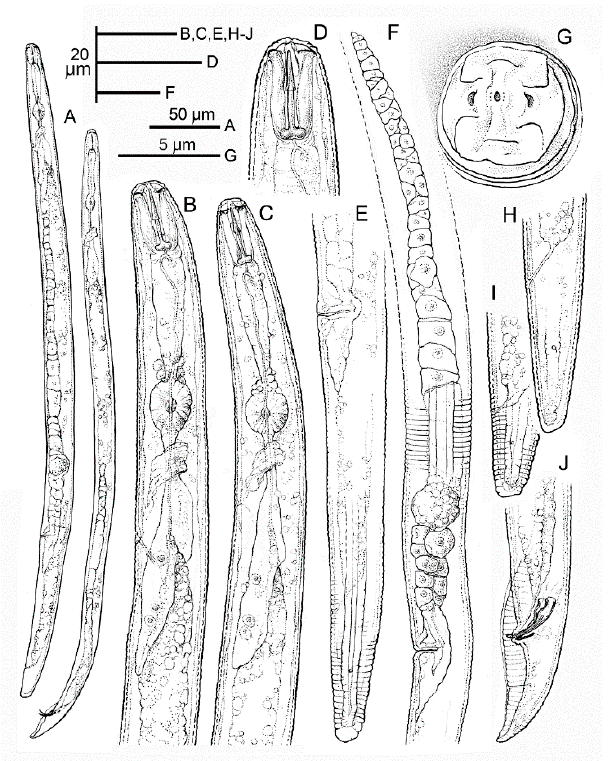
Figure 5. Line drawings of Pratylenchus vovlasi sp. nov. ( A ) entire female and male; ( B – C ) the female ( B ) and the male ( C ) pharyngeal regions; ( D ) detail of the female lip region; ( E ) detail of the female posterior region; ( F ) the female reproductive system with details of the lateral field; ( G ) en face view; ( H , I ) the female tail; ( J ) the male